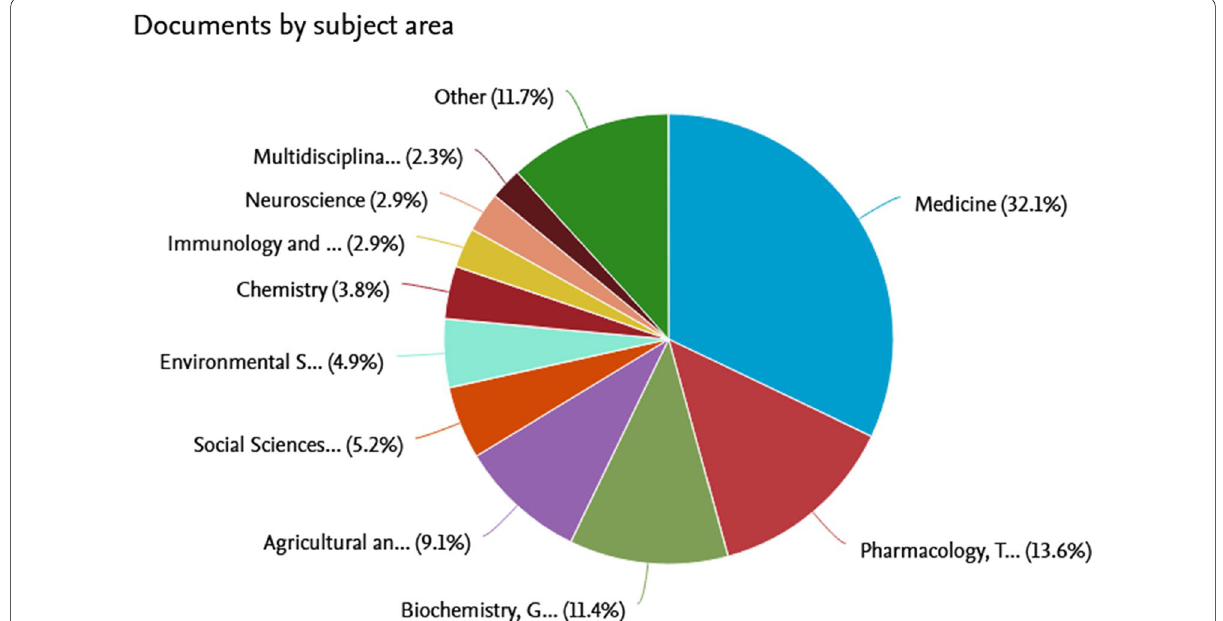
Fig. 4 Different areas of research on C. edulis as per Scopus